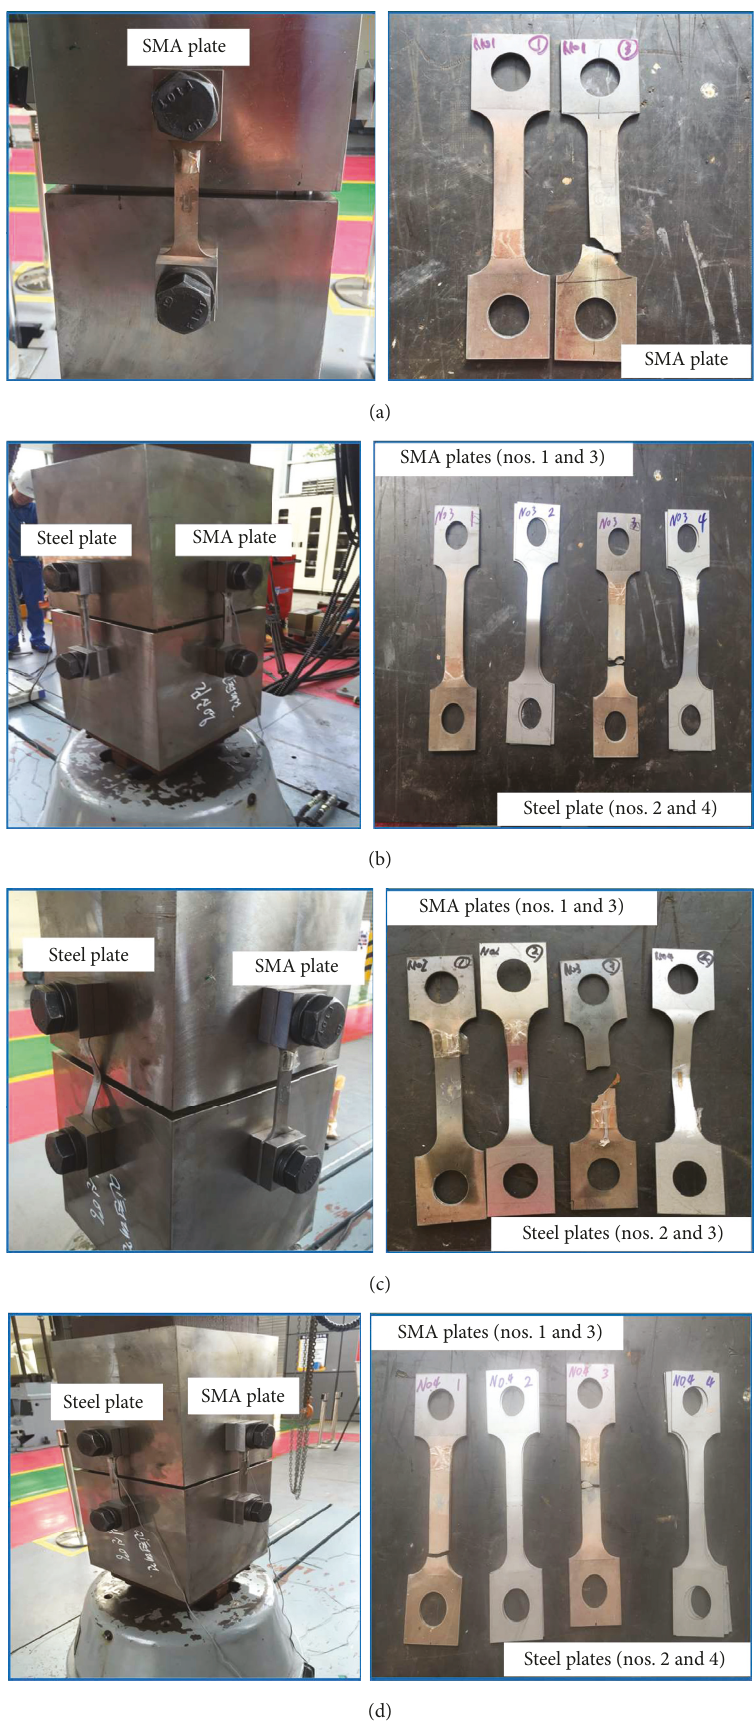
Figure 9: Pictures for experimental results after testing. (a) SMA-BR-1. (b) SMA-BR-2. (c) SMA-BR-3. (d)